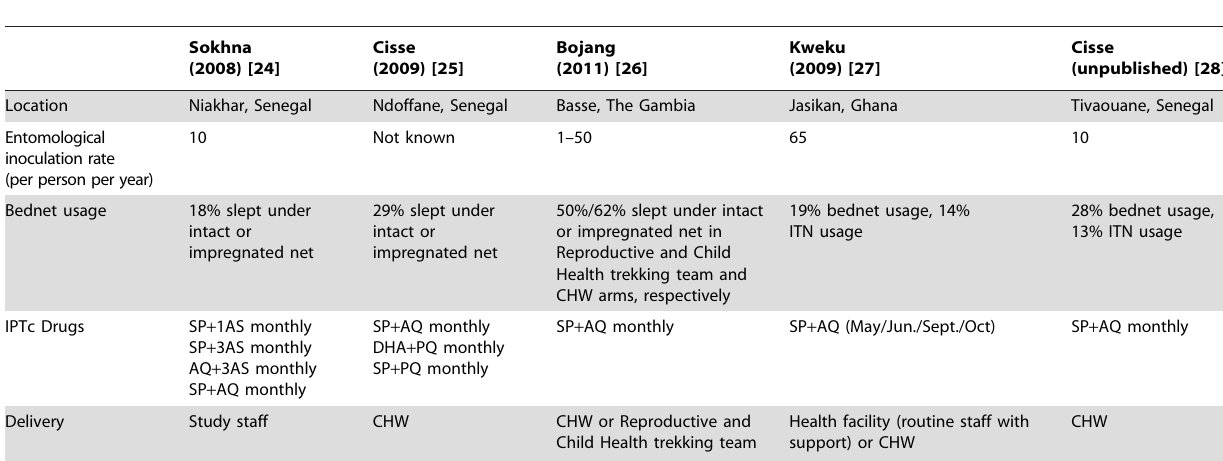
Table 2. Characteristics of Non-controlled